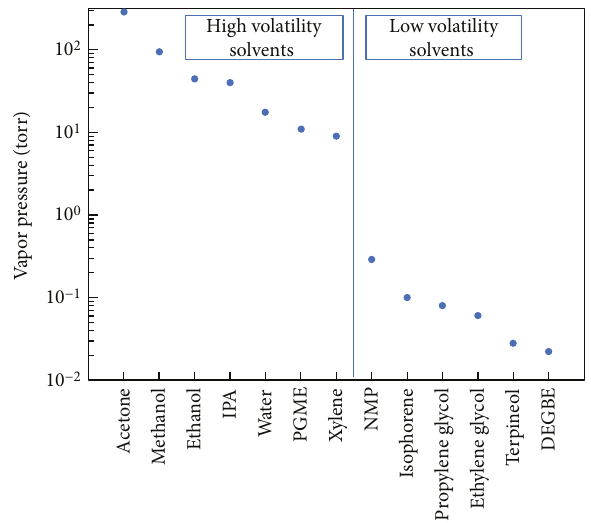
Figure 4: Common high and low vapor pressure solvents for